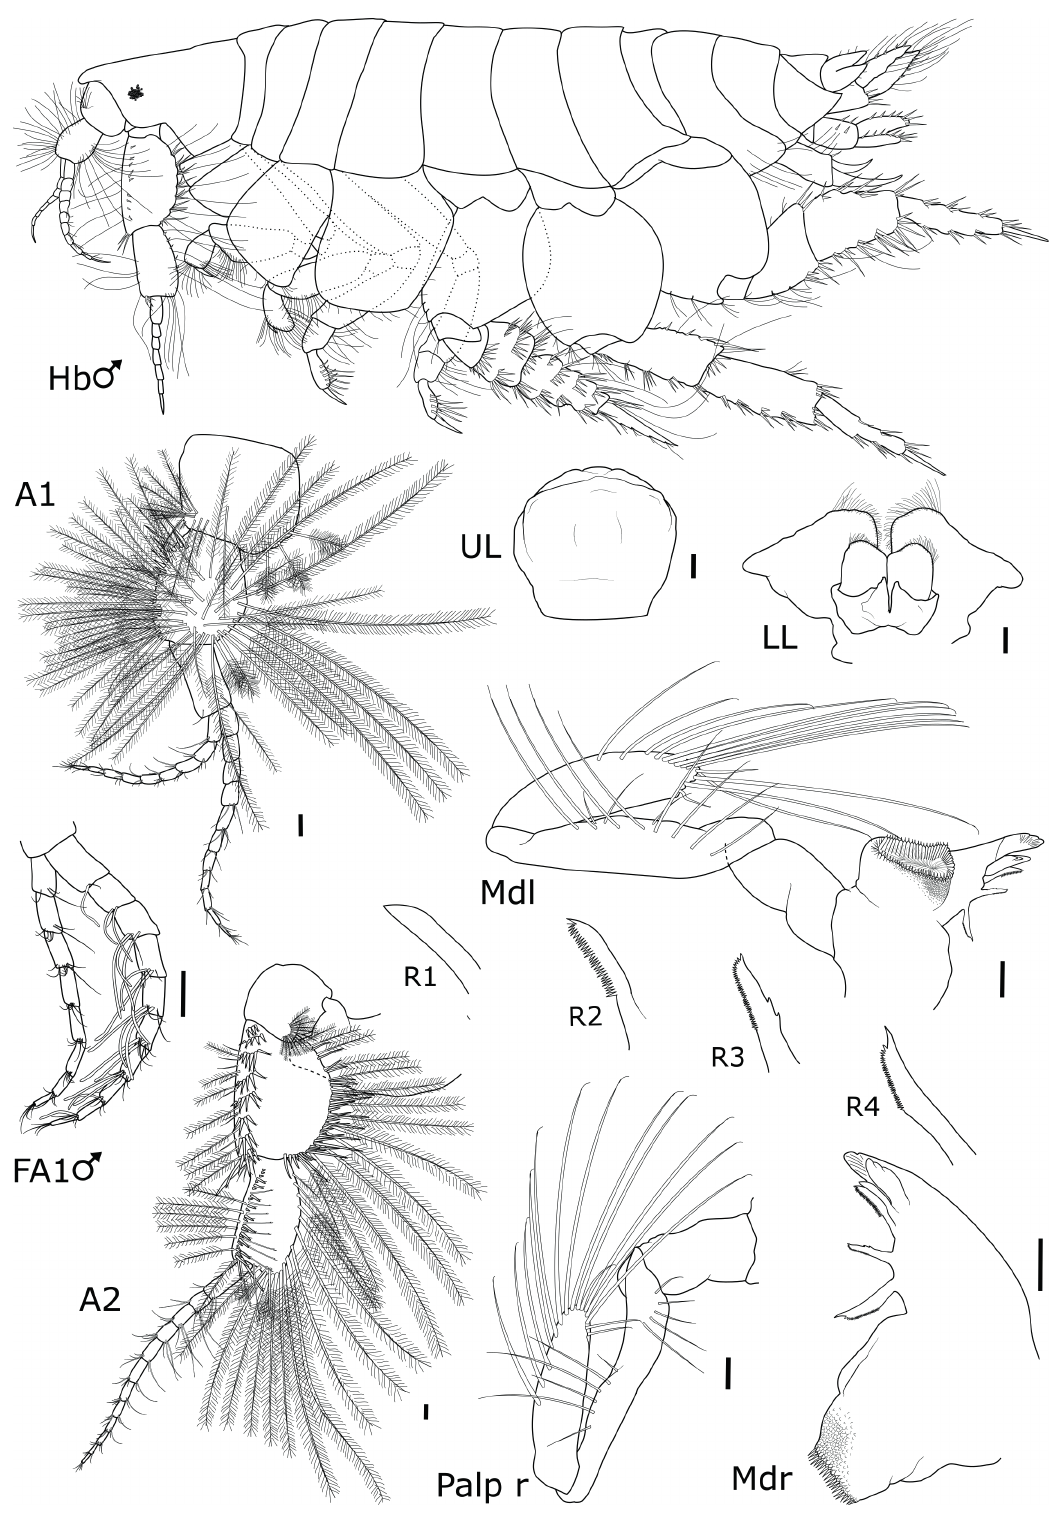
Figure 1 - Phoxocephalopsis ruffoi sp. nov. Female, 7.5 mm, MNRJ 22101: Antennae and mouthparts. Male, 6.9 mm, MNRJ 28745: Habitus and flagellum of antenna 1. Scales = 0.1